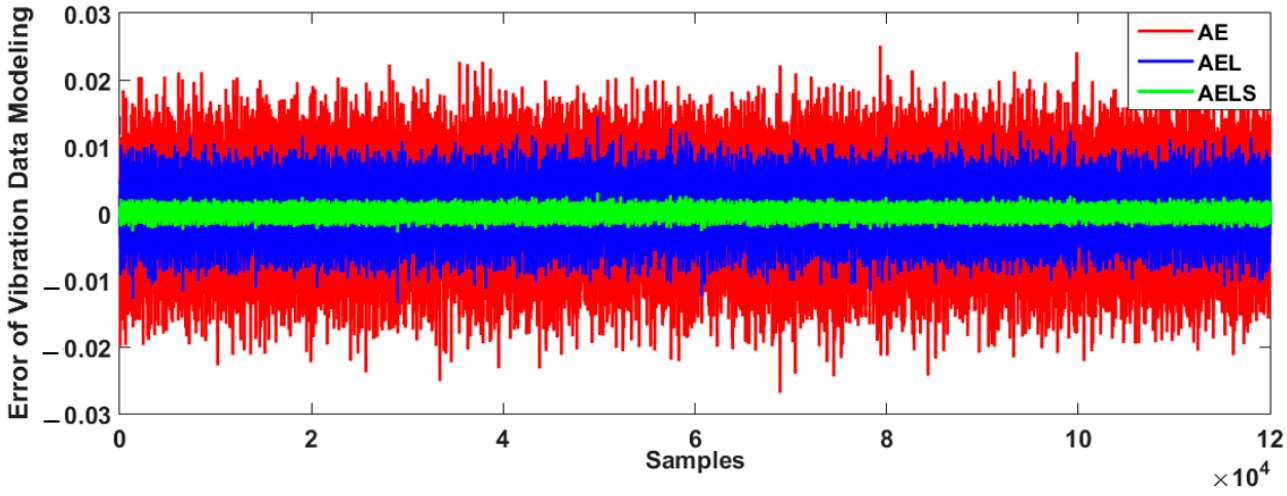
Figure 5. Error of vibration data modeling using AE, AEL, and proposed AELS techniques.